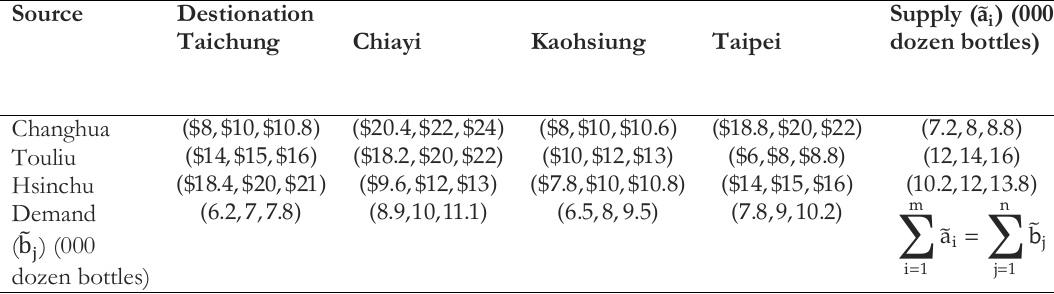
Table 2. Summarized data in the Dali case (in U.S.